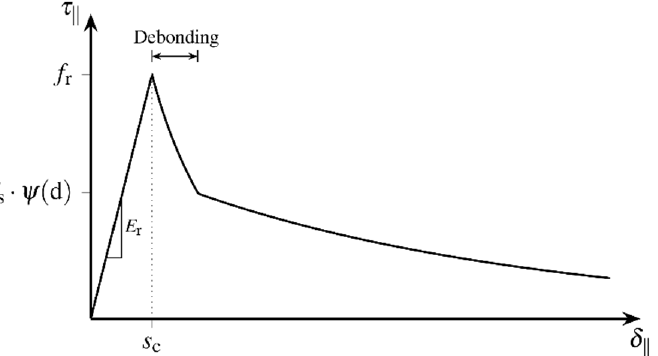
Figure 8. Schematic representation of the bond behaviour with increasing relative displacement regarding the developed bond model (reprinted from [27]).